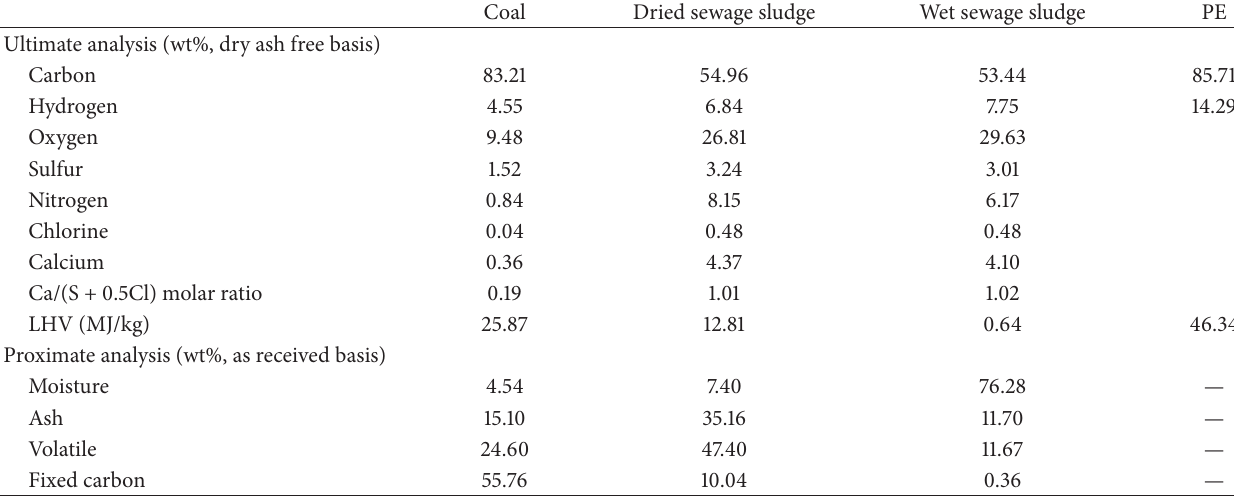
Table 1: Properties of sewage sludge and coal.